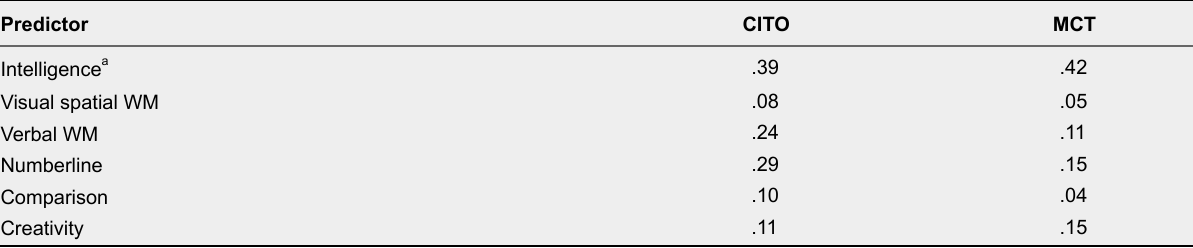
Posterior Estimations of Regression Coefficients of Model